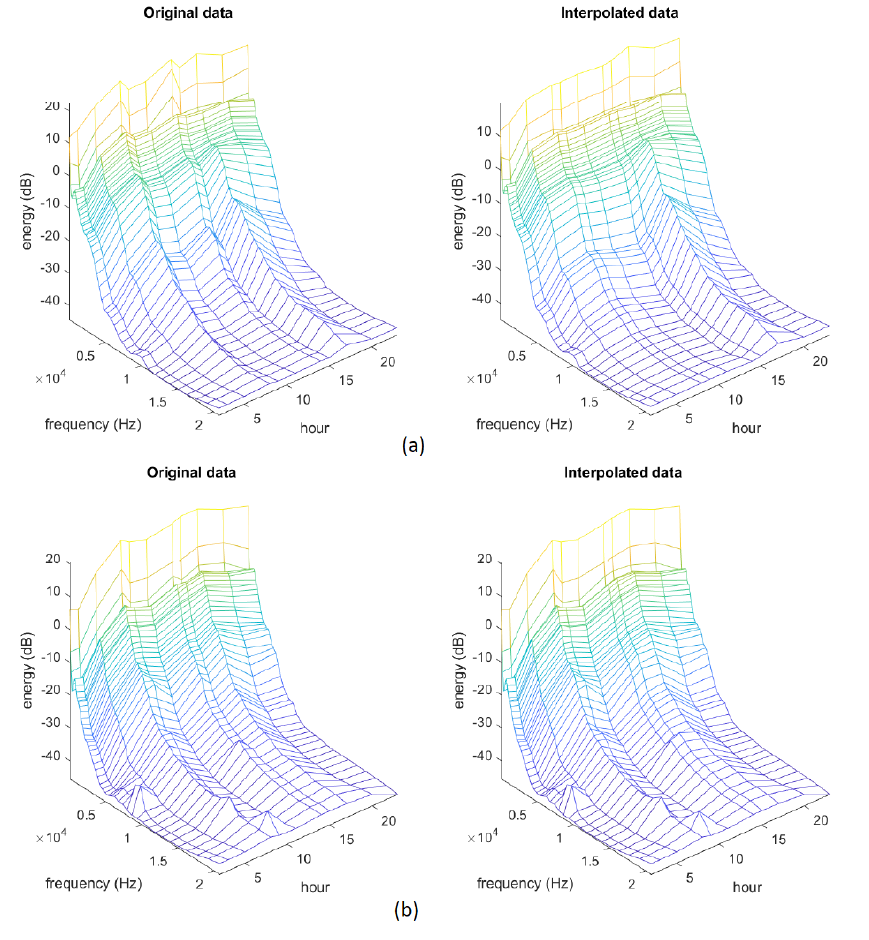
Figure 11. Examples of original (left-side) and interpolated (right-side) STPs for the urban environ- ment from ( a ) sensor hb117 and ( b ) sensor hb145,